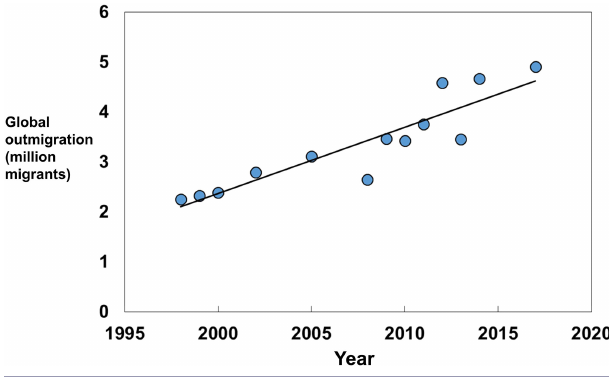
Fig. 2 . Estimated increase of global net migration from Asia, Africa, and Latin America, 1998 to 2017. These are estimates of annual global migration flows from nonreceiver areas, drawn from the U.S. Central Intelligence Agency (CIA) World Factbook (CIA 2014, 2017). Net migration flows were summed among nonreceiver countries that are the source of global emigration flows (i.e., all countries excluding Canada, the United States, Europe, Australia, New Zealand, the Gulf States, Saudi Arabia, Japan, and Singapore). The plotted line represents the linear regression trend of annual data, which is significantly positive at p < 0.0001 using Kendall’s tau for nonparametric